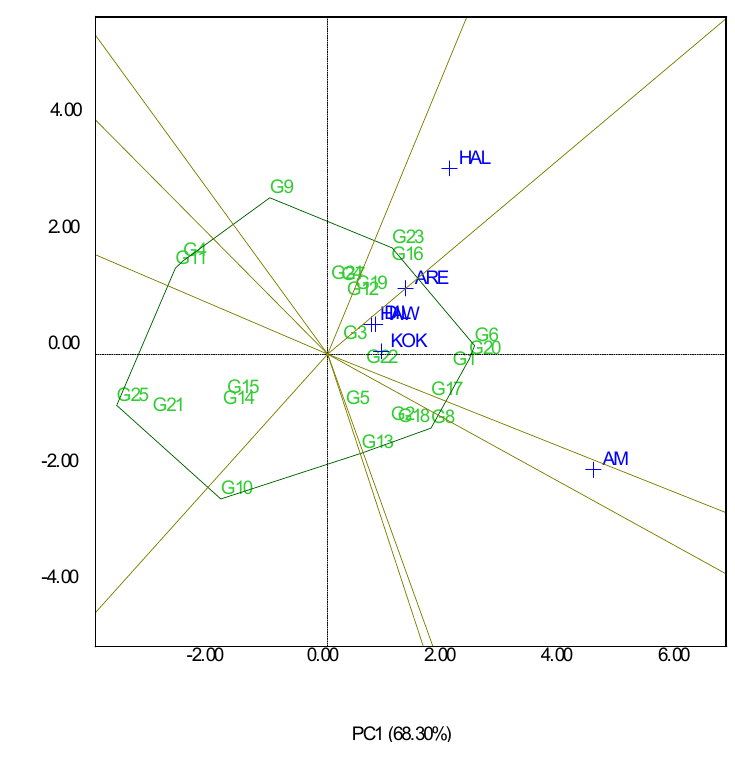
Figure 4 : GGE-biplot showing environments and respective sweetpotato genotypes for fresh root